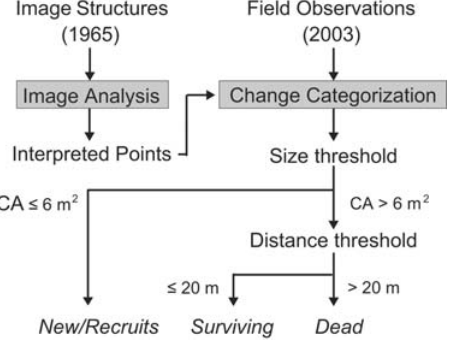
Figure 2. Flowchart. Image structures resembling trees are interpreted and represented as points. Together with trees recorded in field, all points are categorized as belonging to one of three Change Categories. In this process a size (Canopy Area of 6 m 2 ) and distance (20 m) threshold was applied to compensate for GPS inaccuracies and limited image resolution [32]. Trees recorded in 2003 with CA # 6 m 2 are automatically categorized as new .